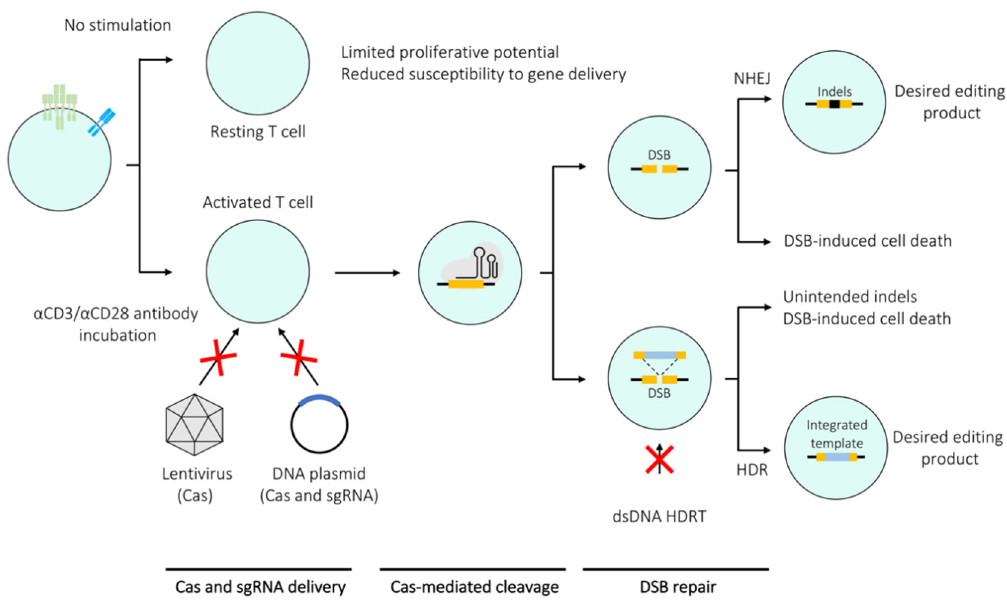
Figure 2. Barriers to editing of primary T cells. There are a number of technical difficulties that contributed to the delayed start of clustered regularly interspaced short palindromic repeats (CRISPR)-based editing of primary T cells. Unstimulated T cells are more difficult to edit due to their limited proliferative potential and reduced susceptibility to gene delivery. Lentiviral delivery of Cas-encoding genes into T cells is feasible, albeit very low editing efficiencies are achieved via this method. Presence of various DNA immunosensors in T cells means that bare double-stranded DNA (dsDNA) serves poorly as a vector for CRISPR components and homology directed repair templates (HDRT). The double-strand breaks (DSB) induced by Cas nucleases are associated with cellular toxicity and may eventually lead to cell death. Due to the competition between the non-homologous end joining (NHEJ) and homology directed repair (HDR) pathways, the HDR-based knockin may lead to unintended indels in a proportion of edited cells.